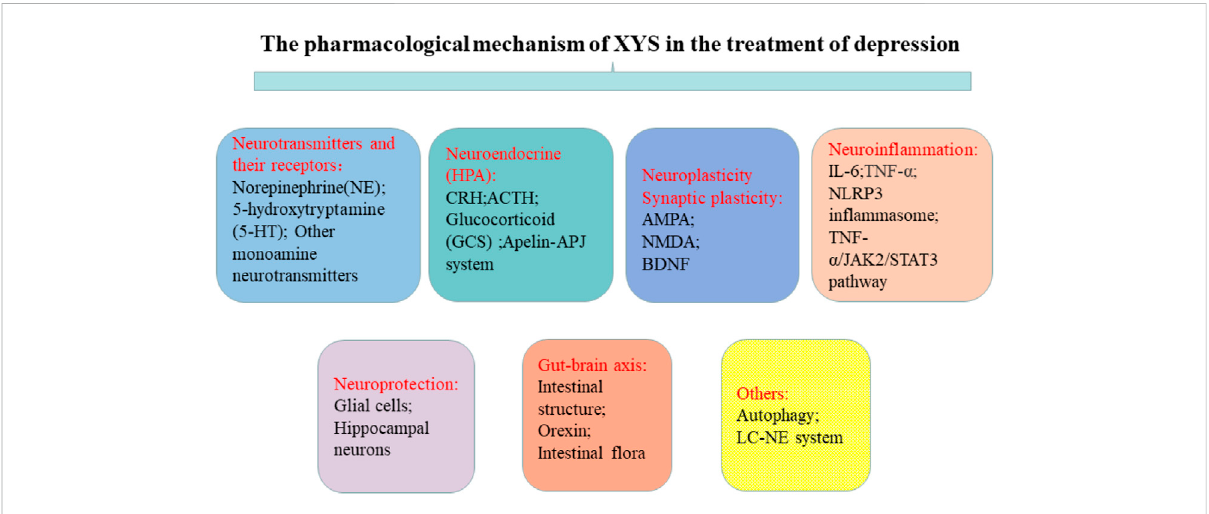
FIGURE 1 Potential therapeutic targets based on the pathogenesis of depression. The treatment goals of depression include neurotransmitters and their receptors, neuroendocrine (HPA), neuroplasticity synaptic plasticity, neuroin fl ammation, neuroprotection, and the gut-brain